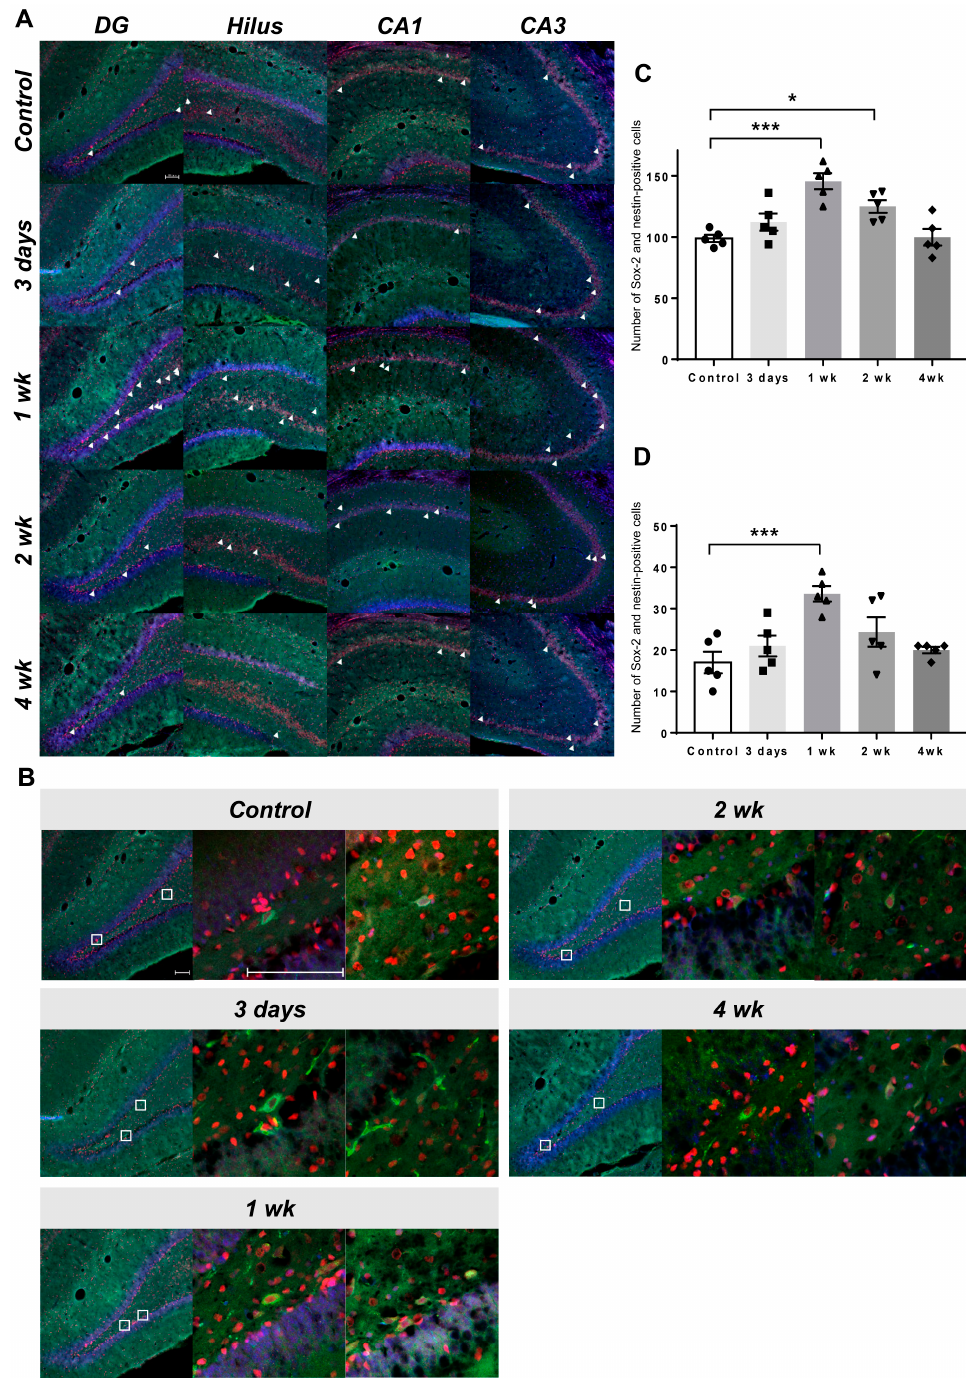
Figure 3. Co-immunostaining for Sox-2 and nestin in control and LIFUS groups. ( A ) Histological staining with DAPI (blue), anti-Sox-2 (red), and anti-nestin (green) in the DG, hilus, CA1, and CA3 of the hippocampus. White arrow: Sox-2 and nestin-positive cells. ( B ) 10x photo of the DG of each group and 40x magnification of the co-expression region. White square: enlarged region. ( C ) Results of co-localization of Sox-2 and nestin-positive cells in hippocampus. ( D ) Results of co-localization of Sox-2 and nestin-positive cells in DG. Data are expressed as the mean ± standard error of the mean. n = 5 animals for each group. * p < 0.05, *** p < 0.001; one-way ANOVA with Tukey’s post hoc comparisons was used to analyze the data. Scale bar, 100 μ m. CA, cornu ammonis; DAPI, 4 ′ ,6-diamidino-2-phenylindole; DG, dentate gyrus.